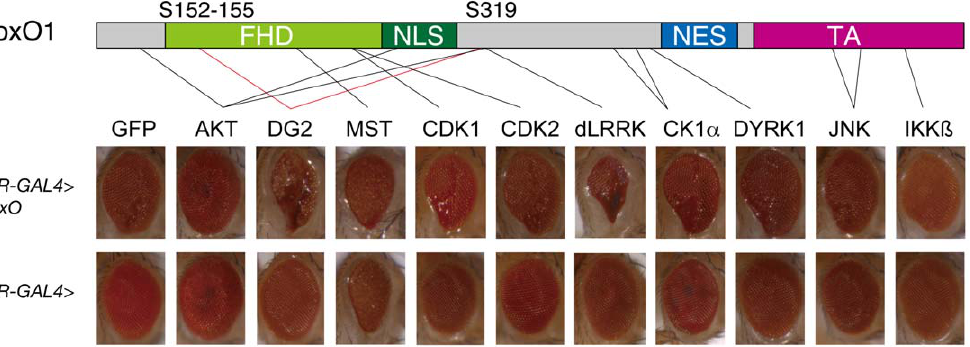
Figure 1. Screening of kinases that affect the eye phenotypes caused by dFoxO. Drosophila orthologues of reported FoxO kinases were expressed with (upper row) or without (lower) dFoxO in Drosophila eyes using the GMR-GAL4 driver. GFP served as a control. The Drosophila DG2 is presumably functionally equivalent to the vertebrate cGKII. Reported phosphorylation sites and newly identified sites that are phosphorylated by cGKII (S152–155 and S319) in human FoxO1 are indicated by black and red lines, respectively. FHD, forkhead domain; NLS, nuclear localization signal; NES, nuclear export signal; TA, transactivation domain. Overexpressing lines used for crosses are: UAS-GFP (GFP), UAS-AKT1 (AKT), UAS-DG2 (DG2), UAS-hippo (MST), UAS-CDK1-Myc (CDK1), UAS-CDK2-Myc (CDK2), UAS-dLRRK (dLRRK), CkI a EP1555 (CK1 a ), mnb EY14320 (DYRK1), UAS-bsk (JNK), UAS-dIKKß (IKK b ).